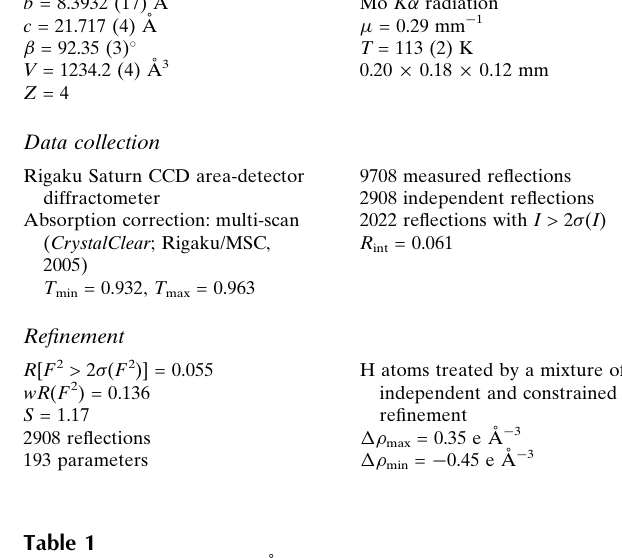
Rigaku Saturn CCD area-detector diffractometer Absorption correction: multi-scan ( CrystalClear ; Rigaku/MSC,